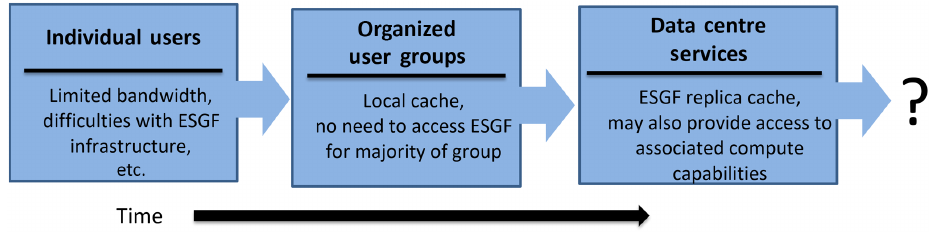
Figure 2. Typical data access pattern in CMIP5 involved users making local copies, and user groups making institutional-scale caches from ESGF. Figure courtesy of Stephan Kindermann, DKRZ, adapted from WIP Licensing White